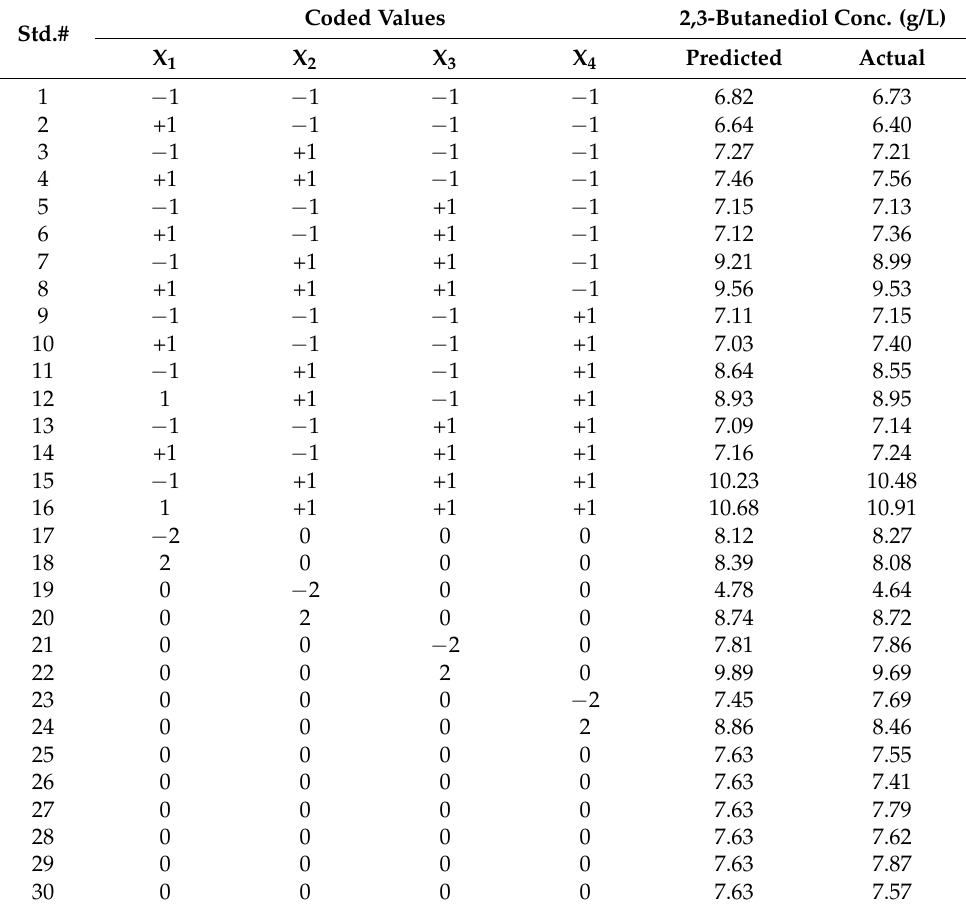
Table 2. Central composite rotatable design and its response from experimental data for 2,3- butanediol